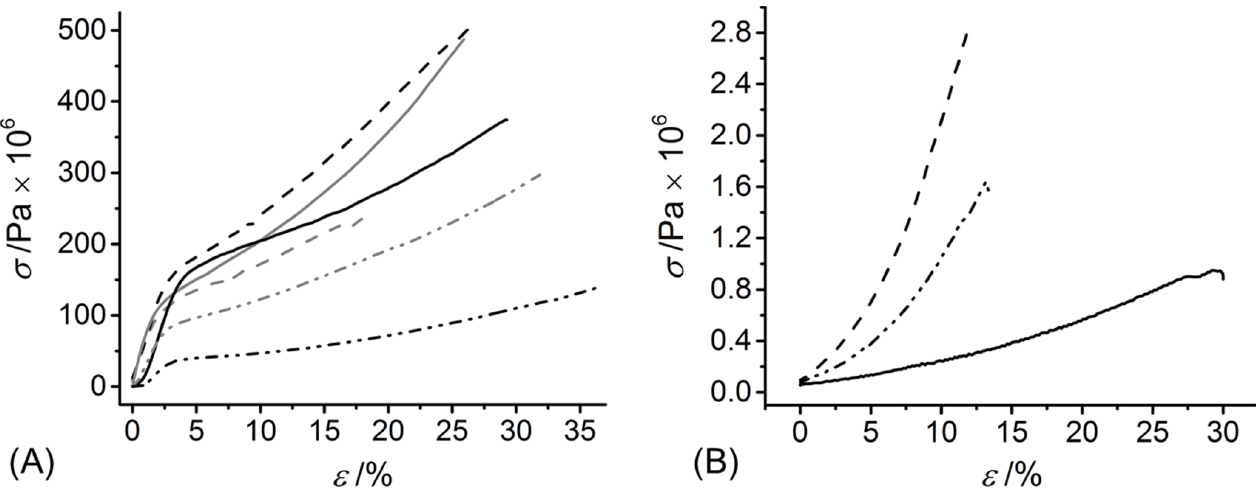
Figure 5. Tensile stress-strain curve of dry ( A ) and hydrated ( B ) wet spun functionalised CRT fibres. ( ─ ): F-GMA, ( ─ ): F- GMA*, ( ─ ∙∙ ─ ): F-4VBC, ( ─ ∙∙ ─ ): F-4VBC*, ( ─ ─ ): F-4VBC-MA, ( ─ ─ ): F-4VBC-MA*.